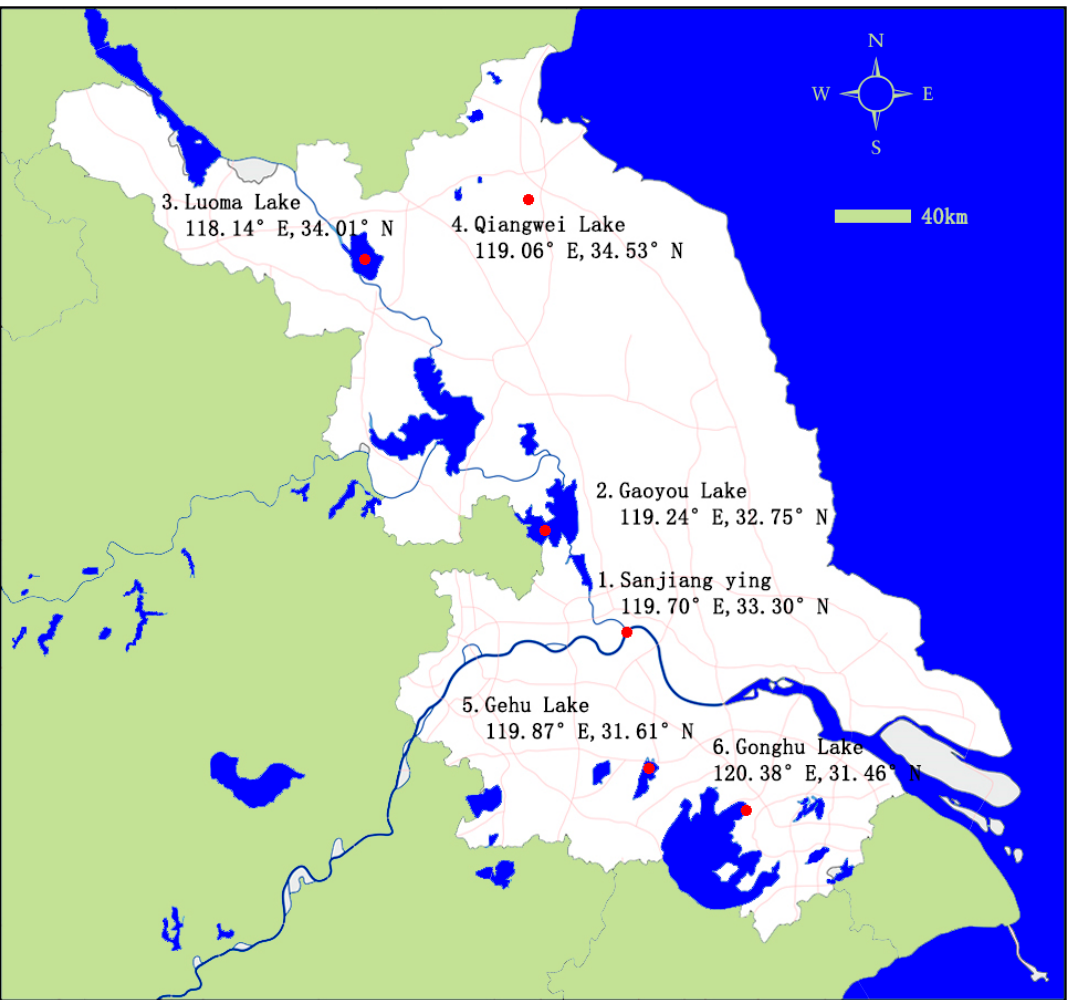
Figure 1. Research area and sampling sites in the study. Numbers 1 to 6 refer to the sampling site at